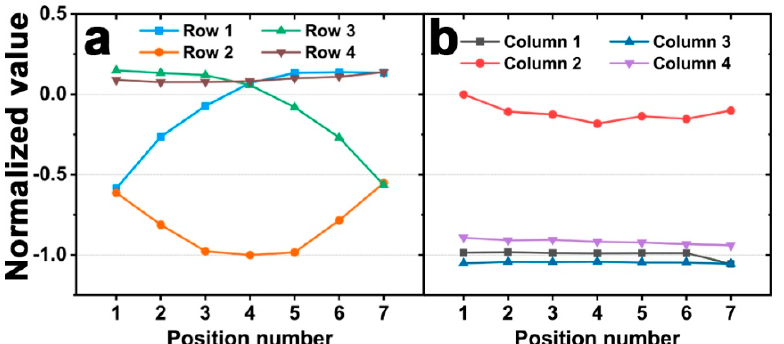
Figure 7. Simulation results of the normalized value from the output voltages of a sensor when 1 N of force was applied between the center of row 1 and 2 to row 2 and 3 in column 2 at ( a ) the row parts and ( b ) column parts. Table 1. The number of mesh elements.